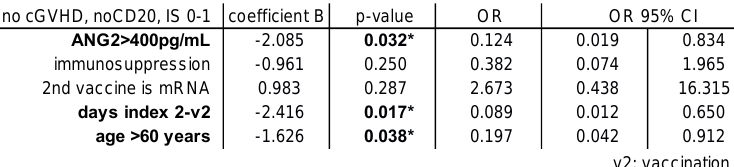
Appendix Figure A2. Factors associated with vaccination response and adverse events in alloSCT patients following COVID-19 vaccination. (a) Box plots showing CD4 and B cell counts (log cells/µL) in patients with cGVHD exacerbation according to positive or negative IgG test (anti-S1 IgG </> 1). Mean (dashed line) and median (horizontal line), points represent individual samples, numbers on the top indicate sample size per group, unpaired t-test; (b) Log10-transformed ANG2 levels (pg/mL) in patients on IS treatment suffering exacerbation of cGVHD (left panel, petrol) versus all others (violet) or in patients with one or more immunosuppressive drugs (right panel). Unpaired t-test. Dashed line: mean, horizontal line: median; (c) Log10-transformed ANG2 levels (pg/mL) according to sIS treatment. Note that patients on two or more sIS drugs have significantly higher ANG2 levels and were therefore excluded from the subsequent logistic regression analysis; (d) Logistic regression analysis reveals high ANG2 as an independent factor associated with an index >20 in the subgroup of patients with less than two sIS drugs, no B cell depleting therapy and no cGVHD exacerbation, as these conditions might influence ANG2 serum levels.* p <0.05.